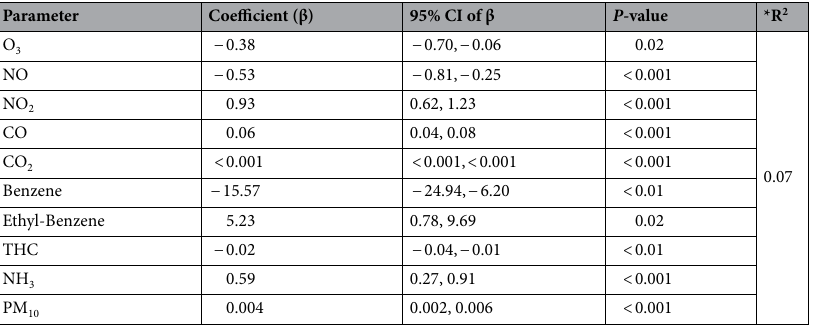
Table 3. Median regression showing the association of various environmental pollutants with UVB/UVA ratio. *Pseudo R 2 . The full model included SO 2 , H 2 S, NO, NO 2 , CH 4 , NCH 4 , THC, O 3 , CO, CO 2 , NH 3 , Benzene, Toluene, Ethyl-benzene, MP-Xylene, O-Xylene, PM 10 , Total solar output, Temperature, Relative humidity, Hour of the day, Season, Station and Year. PM 10 is in µg/m 3 ; Benzene, Ethyl-benzene and Xylene are in PPB, other gaseous pollutants are in PPM. Parameters shown in the table were selected in the backward selection in the final model. Final model also included total solar output, relative humidity, year and season which are not shown in the table.